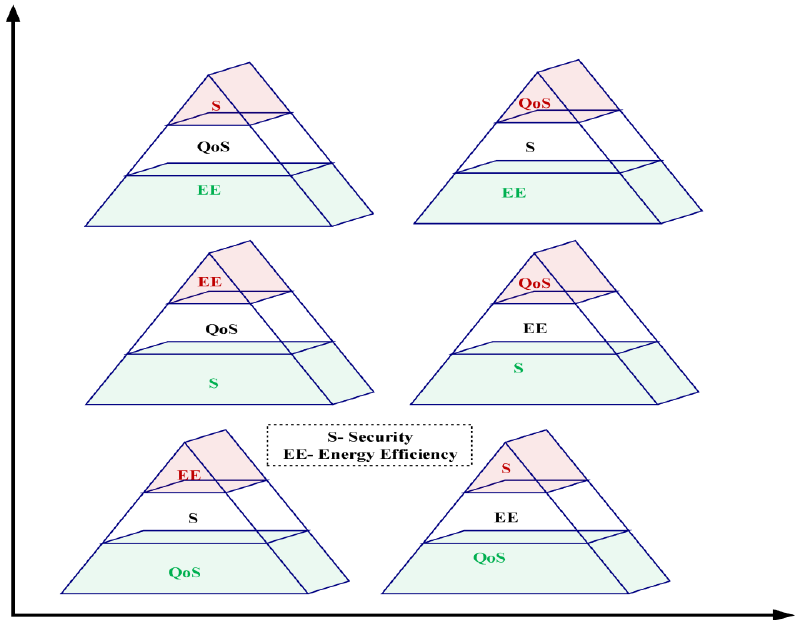
Figure 3. A pyramid view of how optimizations of Energy Efficiency, QoS and Security in a wireless sensor network are related to each